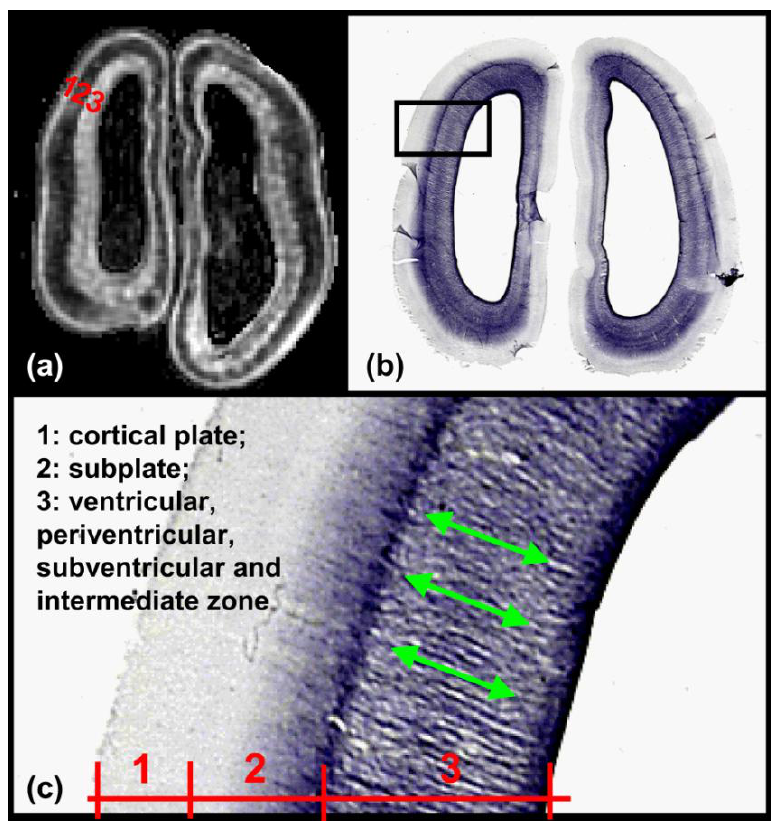
FIGURE 4. The axial slices of the FA map (a) and correspondent histological slide (b) of a 17- week fetal brain demonstrate laminated layers in the cerebral wall. Three layers with one layer of lower FA value nested in the two layers of higher FA are displayed in the FA map (a). These three layers are labeled with the red numbers. Enlargement of the cerebral wall in the black box of the histological slide (b) is shown in (c). The correspondent three layers can be identified and annotated in (c). Especially, the radial structures in the layer close to the ventricle are prominent. Green arrows in (c) indicate the orientations of these radial